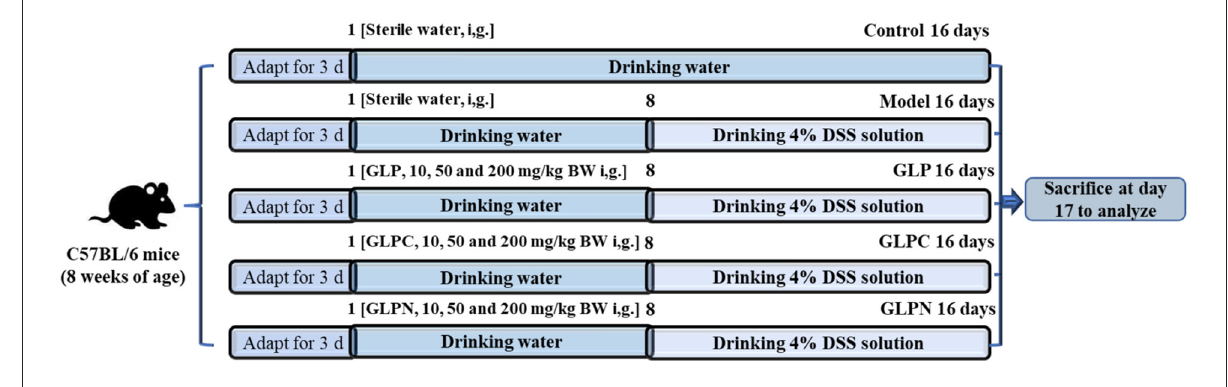
FIGURE1 Animal experimental